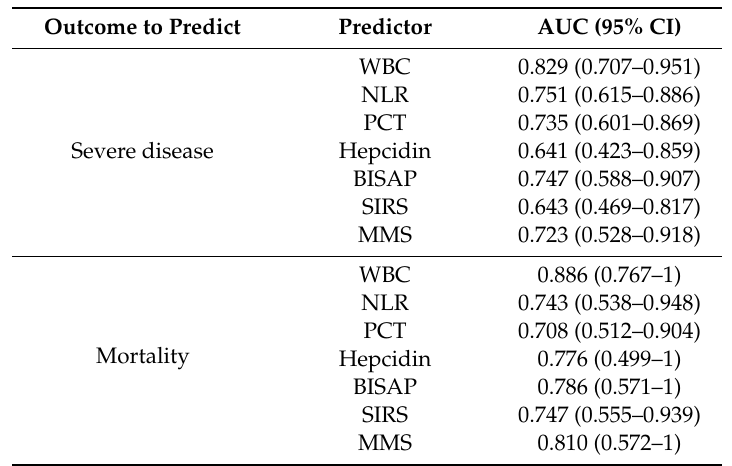
Figure 2. ROC curves of WBC: white blood count; NLR: neutrophil / lymphocyte ratio, SIRI: systemic inflammatory response index; PLR: platelet / lymphocyte ratio; CRP: C-reactive protein; PCT: procalcitonin; hepcidin; BISAP: bedside index of severity in acute pancreatitis; SIRS: systemic inflammatory response syndrome; and the MMS: modified Marshall score, at 48 h of symptom onset; ( a ) the ROC curves for the prediction of acute biliary pancreatitis severity; ( b ) the ROC curves for the prediction of acute biliary pancreatitis mortality. Table 2. Area under the receiver operating characteristics curve for the prediction of severe disease and mortality on admission.